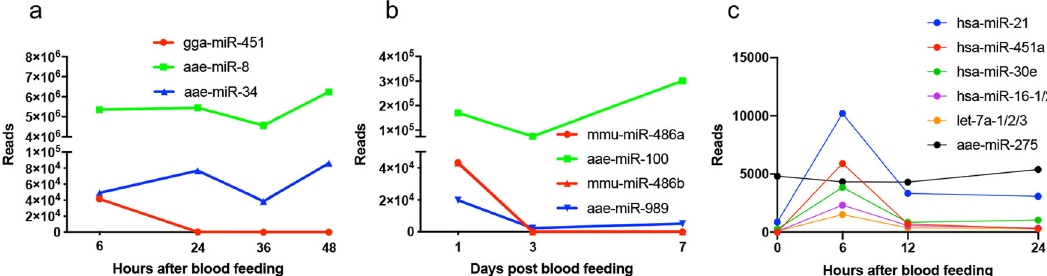
Fig. 1 Vertebrate miRNAs are abundant in Ae. aegypti after blood feeding. Examples of reads of different miRNAs in deep sequencing data from a the fat body of Ae. aegypti mosquitoes fed on chicken blood 23 , and b Ae. aegypti whole body fed on mouse blood 24 . miRNAs with pre fi x aae, mmu, and gga represent miRNAs from Ae. aegypti , mouse, and chicken, respectively. c Analysis of small RNA-Seq data revealed the presence of the top fi ve most abundant human miRNAs in the dissected fat body of mosquitoes after blood feeding with the peak of abundance at 6 h after blood feeding. Each dot point represents the average of three biological replicates. aae-miR-275 is included as an endogenous Ae. aegypti miRNA for